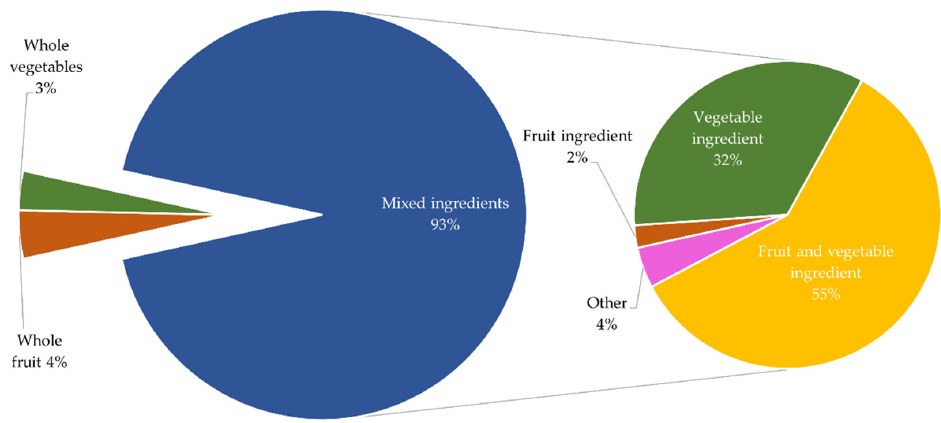
Figure 2. Ingredients within healthy snacks nominated by children (pre-program).